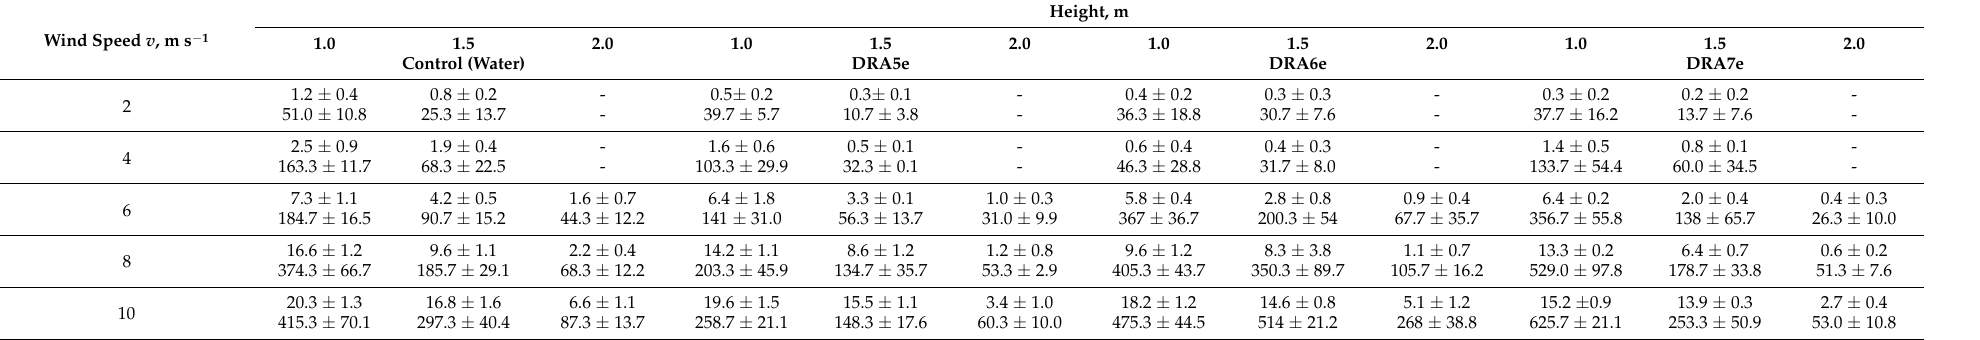
Table 5. Water-sensitive paper coverage (upper line, %) and number of droplets (lower line) at 5 m from the target zone of the sprayer (1.0–2.0 m height measured vertically in direction of the y -axis from ground, Figure 3) by five air-injector flat spray nozzles with a sprayer.